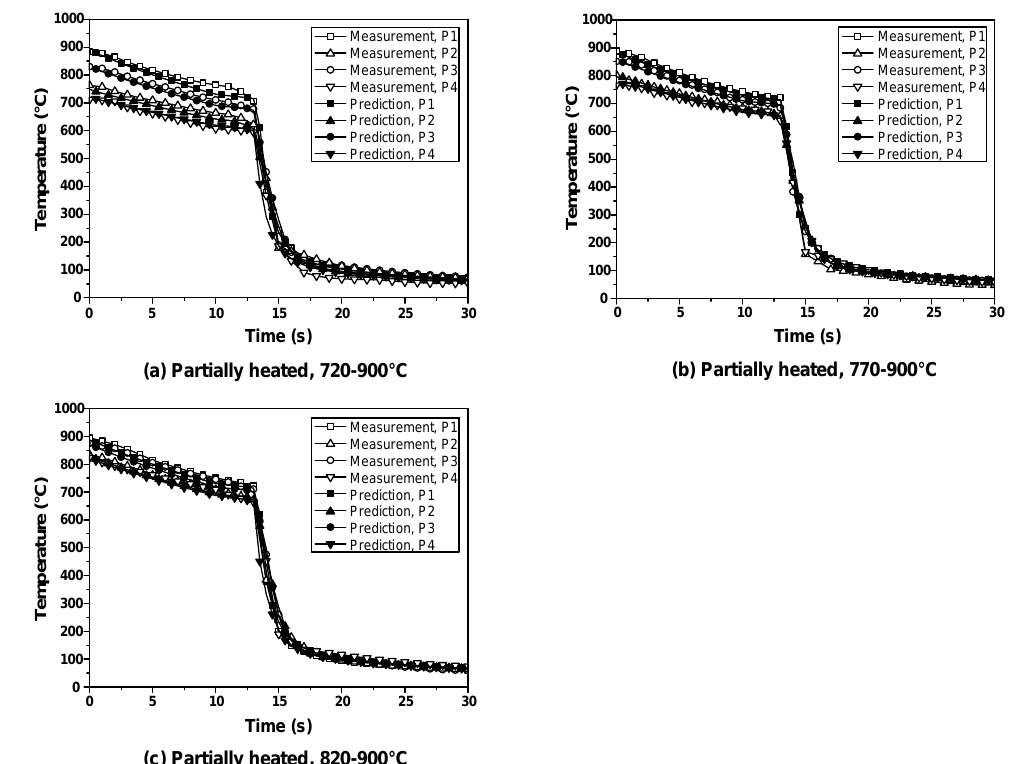
Figure 14. Comparison of the cooling histories between the measurement and prediction.